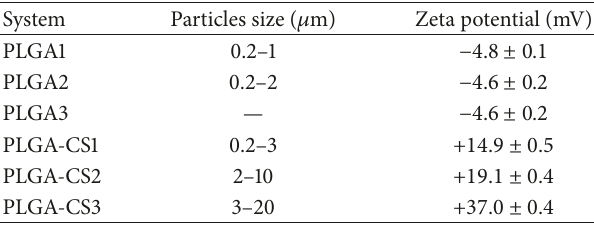
Table 2: Particles size and zeta potential of PLGA-CS MPs.